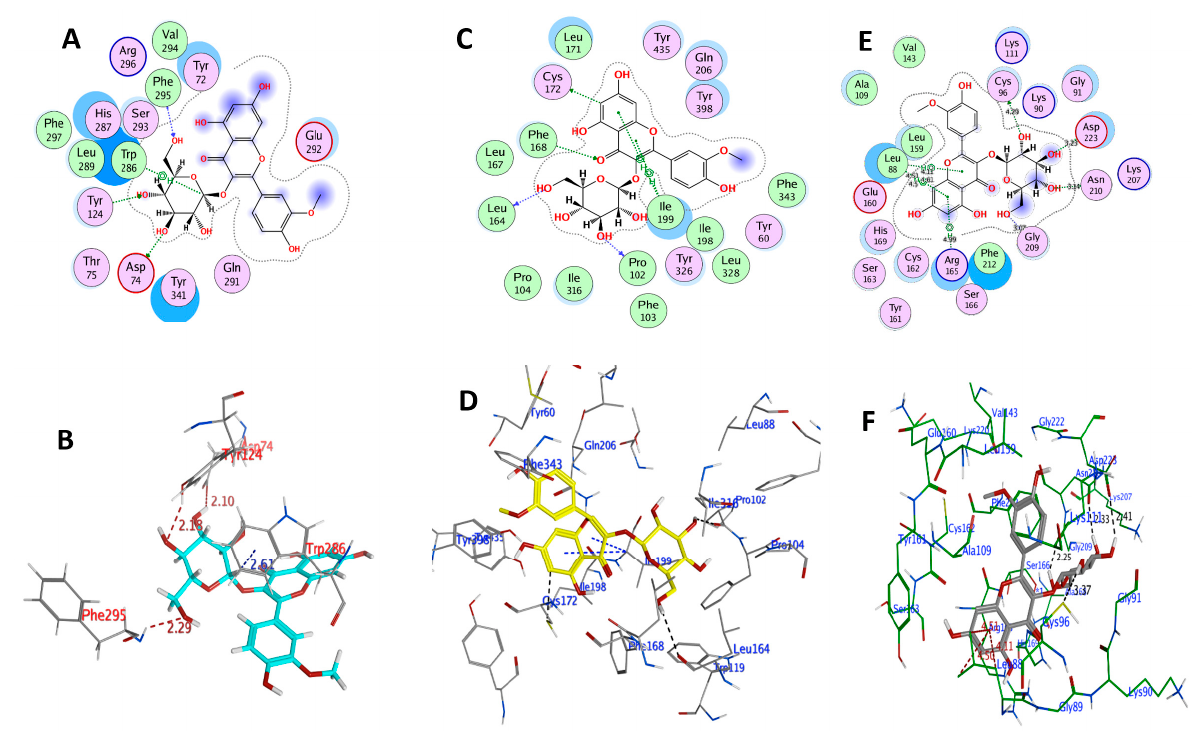
Figure 6. Docked conformation of IR3G within the binding pocket of AChE, MAO, and PLK2 as depicted in ( A , C , E ) for 2D docking poses; and in ( B , D , F ) for 3D docking poses, respectively.